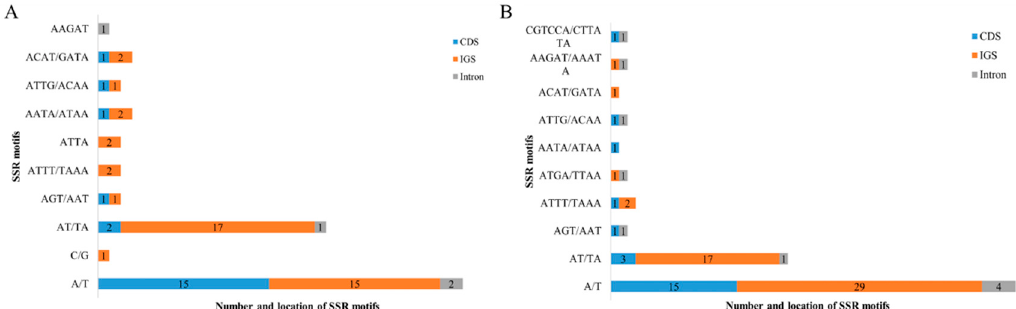
Figure 4. The types and distribution of SSRs along the chloroplast genomes of G. orientalis ( A ) and G. officinalis ( B ). Different locations, including CDS, IGS and intron regions, are represented as col ‐ ored boxes.